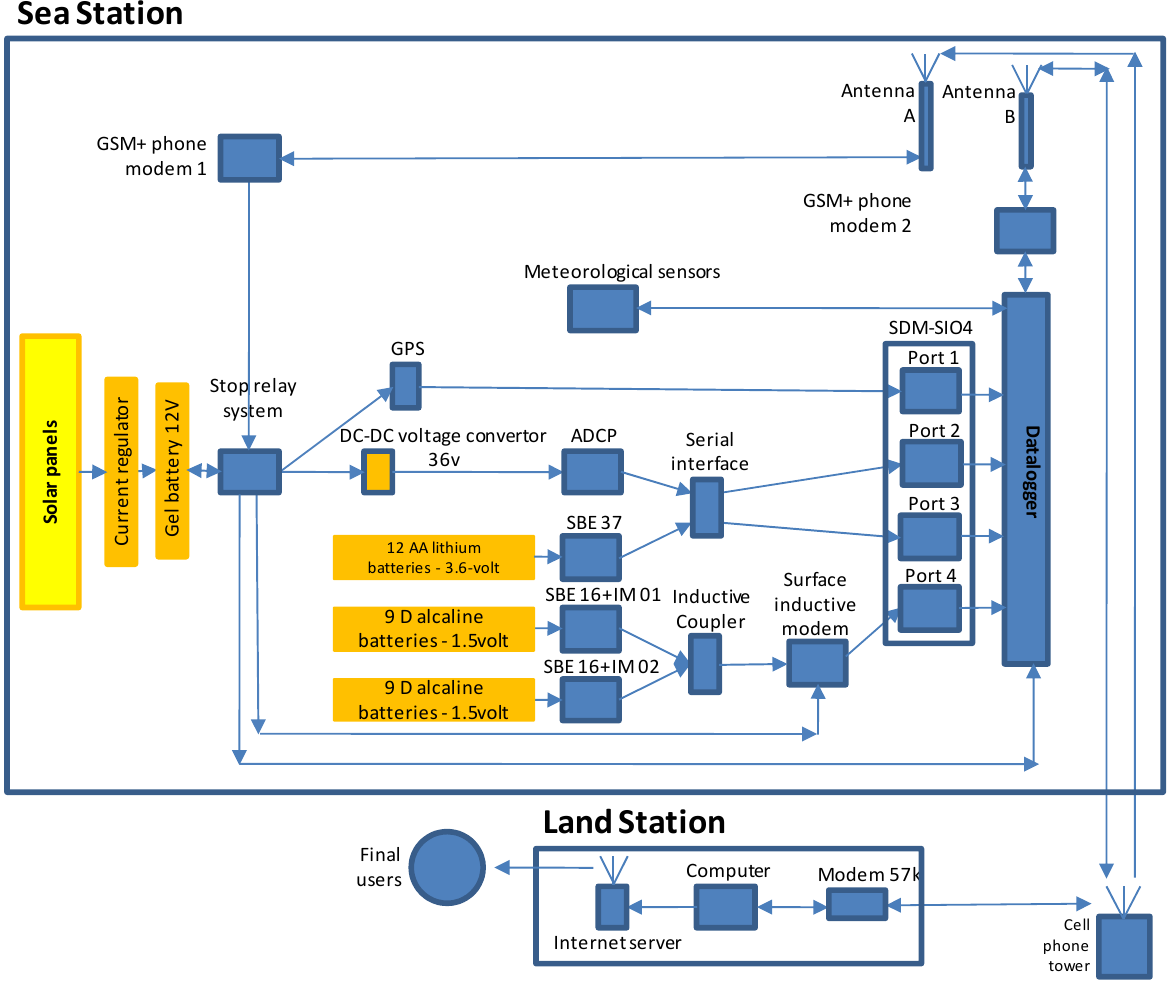
Figure 4. The flux diagram of the electric assemblage connecting the different sensors and powering sources of OOCS. This scheme is presented also in relation to the telemetry system used for data communication, storage and use at the land